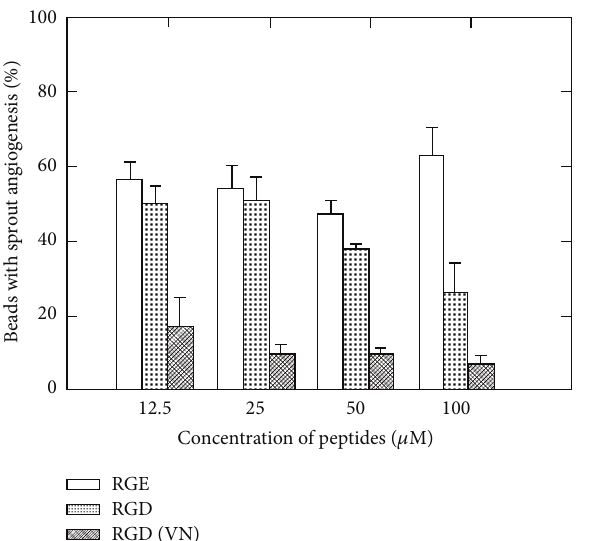
Figure 7: Effect of GPenGRGDSPCA peptides (RGD (VN)) on sprout angiogenesis of HDMEC in fibrin. HDMEC cultured on microcarrier beads were incubated with various doses of RGD (VN) (12.5 micro M–100 micro M) peptides at RT for 1hr. The EC-beads were added to fibrinogen solution with presence of VEGF (30ng/mL) and bFGF (25ng/mL) and then polymerized with thrombin. RGD (VN) significantly inhibited sprout angiogenesis of HDMEC in fibrin compared to GRGESP(RGE) control peptides and nonspecific integrin antagonist cyclic RGD peptide